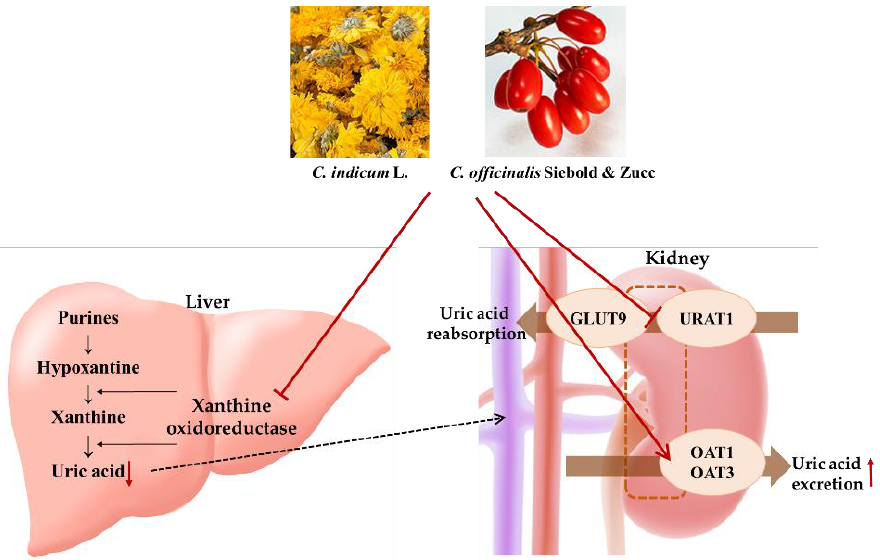
Figure 7. Schematic representation of the effect of Ci, Co, or FSU-CC on hyperuricemia. Ci, Co, or FSU-CC inhibited the production of uric acid in the liver and excretion of uric acid in the renal cells. Author Contributions: O.-K.K. and J.L. designed the experiments; O.-K.K., J.-M.Y., M.L., and D.K. performed the experiments; J.-M.Y. and M.L. analyzed the data; O.-K.K. and J.L. wrote the manu- script. All authors have read and agreed to the published version of the manuscript.